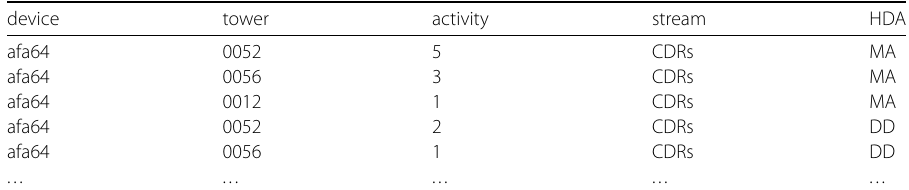
... ... Table 2 Structure of the ground truth dataset. Each record describes a device and the three closest towers to the device owner’s actual home location device closest 2nd closest 3rd closest afa64 0003